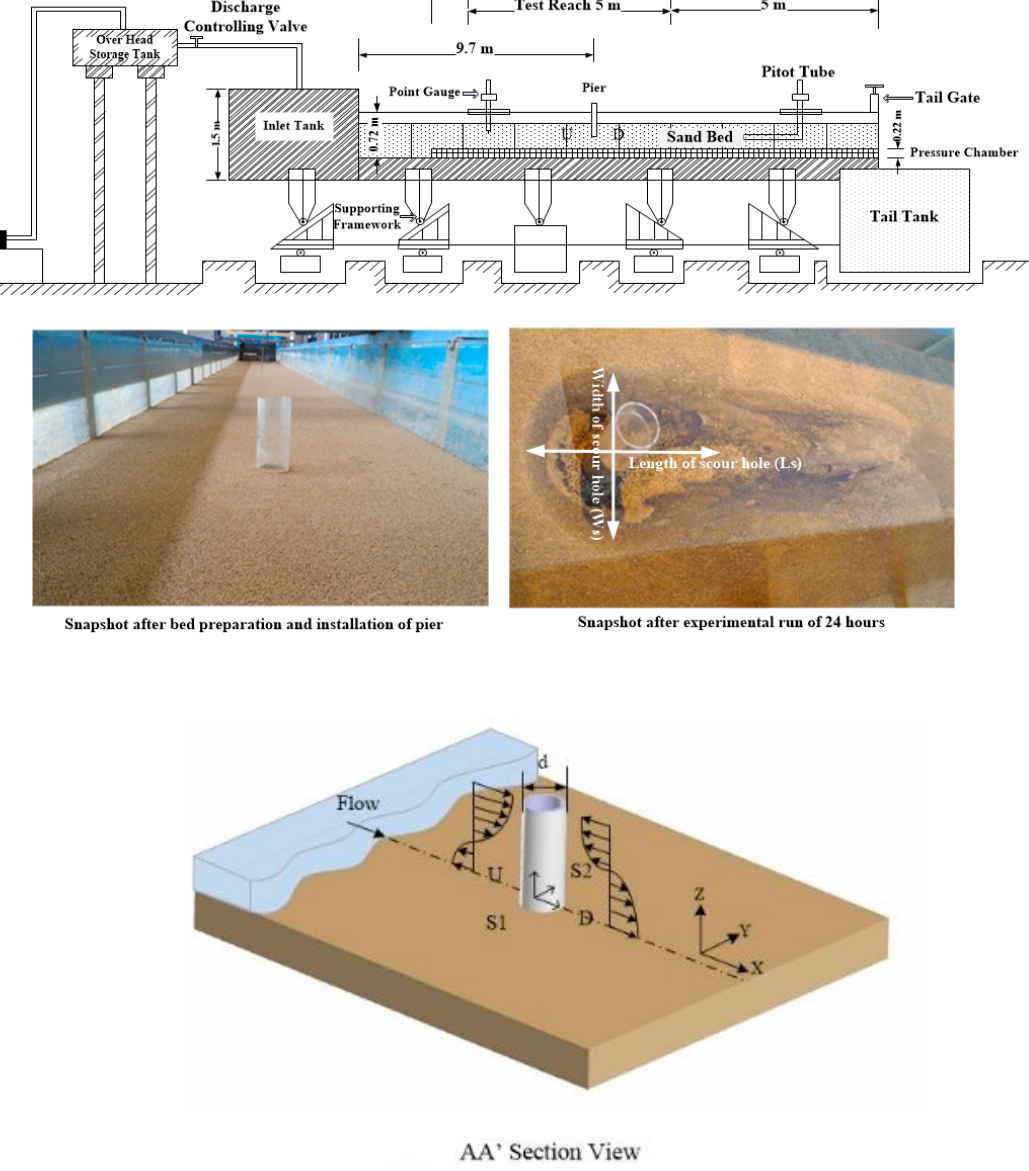
Figure 1. Schematic diagram of the experimental set-up .